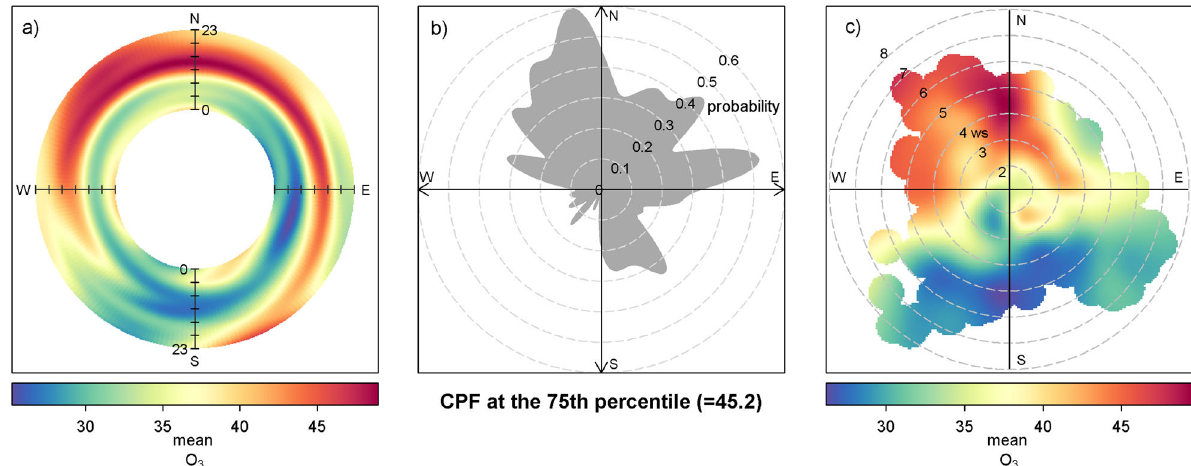
Fig. 2 Identifying potential sources of increased ozone (O 3 ) concentrations at the sampling site. a Polar annulus plot depicting the mean hourly O 3 concentrations for the entire study period. b Conditional probability function (CPF) plot of O 3 concentrations above the 75th percentile (45.2 ppbv). c Bivariate polar plot of O 3 concentrations.